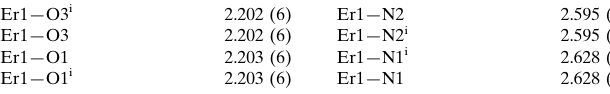
Selected bond lengths (A˚ ).